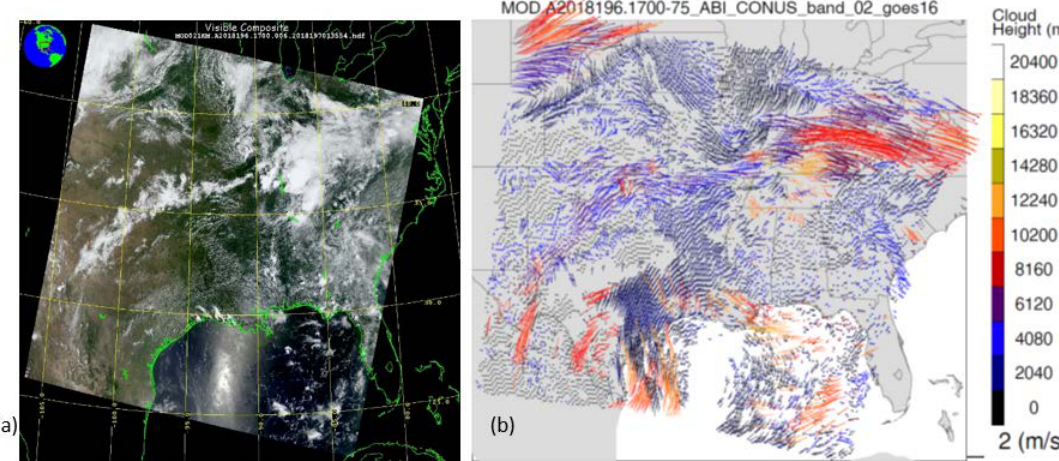
Figure 7. Retrieved 3D-winds states describe the horizontal wind velocities and their pattern heights. Vector lengths in the righthand panel ( b ) are scaled in proportion to wind speed (length scale shows a 2 m/s wind speed) and color-coded according to assigned height (color bar shows height scale). The MODIS true-color composite is shown in the left-hand panel ( a ) for context. Sun glint is apparent in the MODIS composite, which is not found in the GOES imagery because of the difference in viewing geometry between low Earth orbit (LEO) and geostationary Earth orbit (GEO) satellites. The algorithm is unsuccessful in finding matches in the glint region. Any anomalous retrievals (typically << 1%) may be filtered out in a post-processing step or an assimilation quality control test. The case shown is MODIS granule MOD2018196.1700.061 (MODIS band 1) paired with GOES-16 CONUS ABI Band 2. (Note: retrieval sites are thinned 2:1 in each direction for